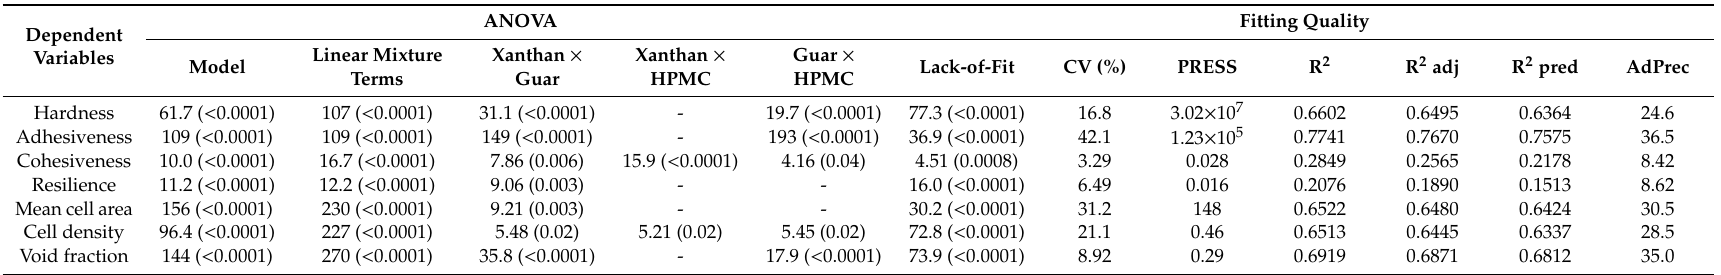
Table 7. Summary statistics of the analysis of variance (ANOVA) showing F-test and p -value (in brackets, Prob > F) of the full model, linear mixture terms, interaction terms and lack-of-fit from polynomial models fitted on GF bread crumb textural properties and crumb grain features image analysis. Goodness-of-fit measures including coe ffi cient of variation (CV), predicted residual error sum of squares (PRESS), coe ffi cient of determination ( R 2 ), adjusted R 2 ( R 2 adj), predicted R 2 ( R 2 pred), and adequate precision (AdPrec) are also